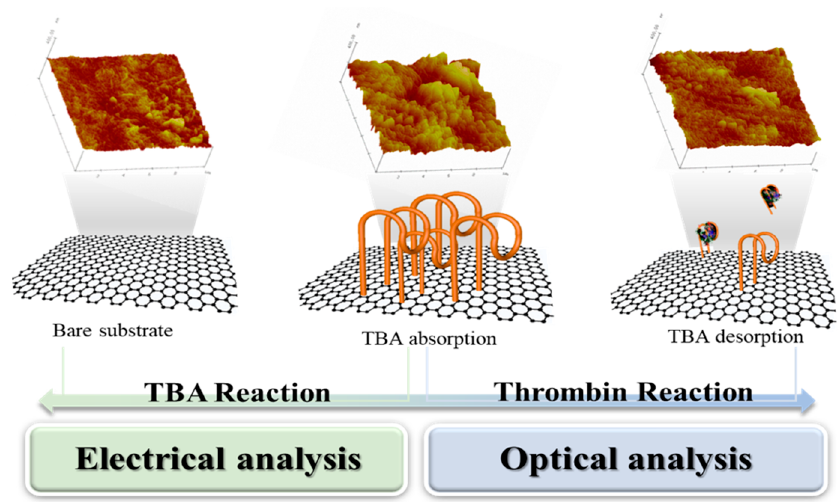
Figure 1. The schematic view of main theme which is comparison between electrical and optical analysis for attachiment of aptamer and detachment of aptamer by thrombin. The attachment and detachment of aptamer was verified with atomic force microscopy images.